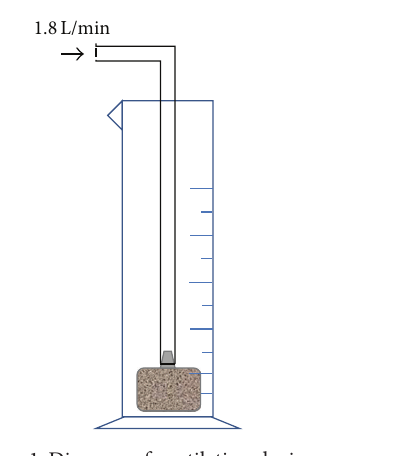
Figure 1: Diagram of ventilation